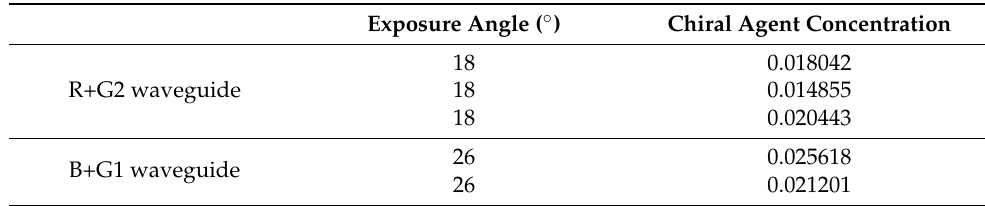
Table 2. Preparation parameters of different PVGs.